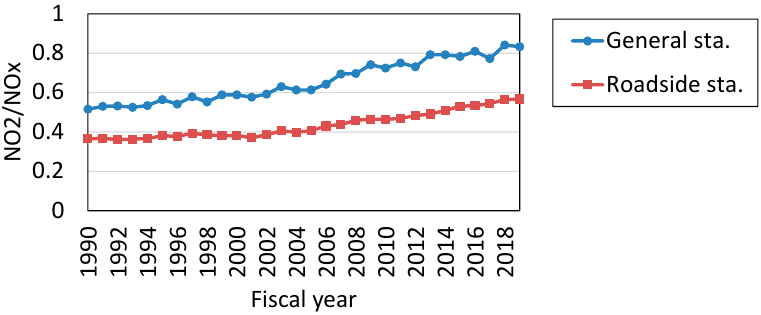
Figure 18. Trends in the annual averages of NO 2 /NOx. NO 2 , NOx: same as Figure 17. Because NO 2 is an important precursor to O 3 , it is extremely significant to know the ratio of NO and NO 2 in NOx from the source . Because the oxidation of NO to NO 2 in the atmosphere occurs by ozone or RO 2 radicals, we analyzed changes over time at night (from 8 p.m. until 5 a.m.) during the cold season (from October to March), when O 3 or RO 2 radicals reduce. The results of this analysis are shown in Figure 19.